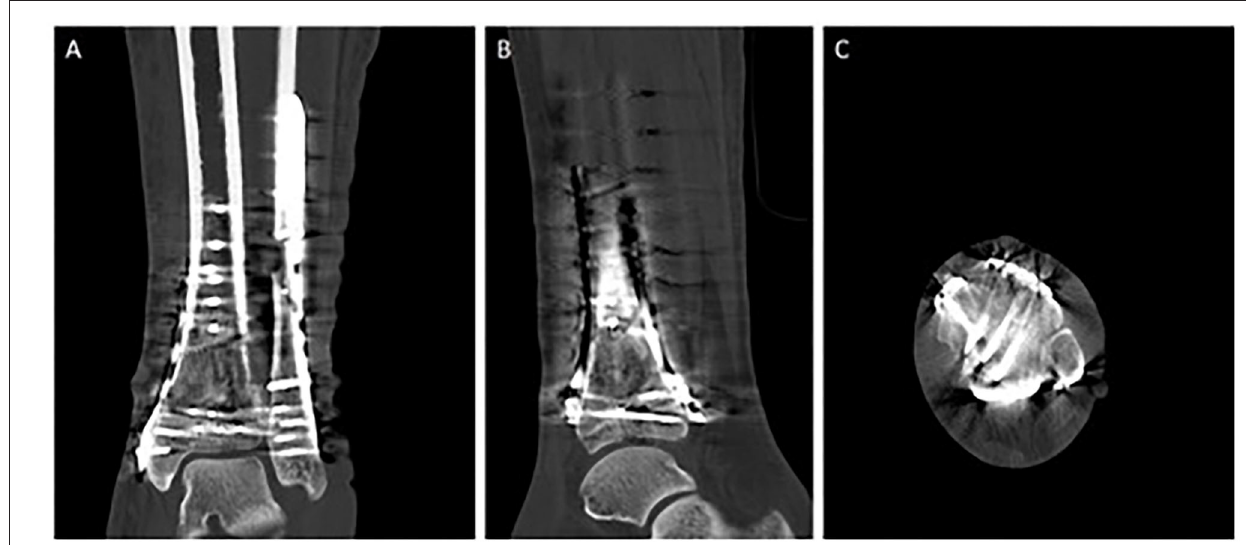
FIGURE 3 | Triple plate ORIF of a tibial pilon fracture AO type 43-C3. Postoperative CT scans [ (A) coronal plane, (B) sagittal plane, (C) axial plane] of a 49-year-old female patient following operative treatment of an AO type 43-C3 tibial pilon fracture, resulting from a hiking accident. As a first step, fracture reconstruction was started with a posterolateral approach to address the dorsal tibial component with a buttress plate. The comminuted fibula was restored in length and rotation afterwards. As a second step, the extensile approach was used to address the anterior and the anteromedial component with two angular stable plates.